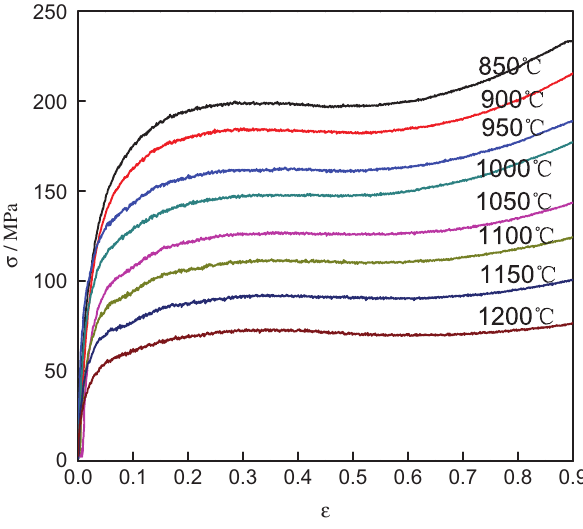
Figure 1: True stress-strain curves of samples deformed under tem- peratures from 850°C to